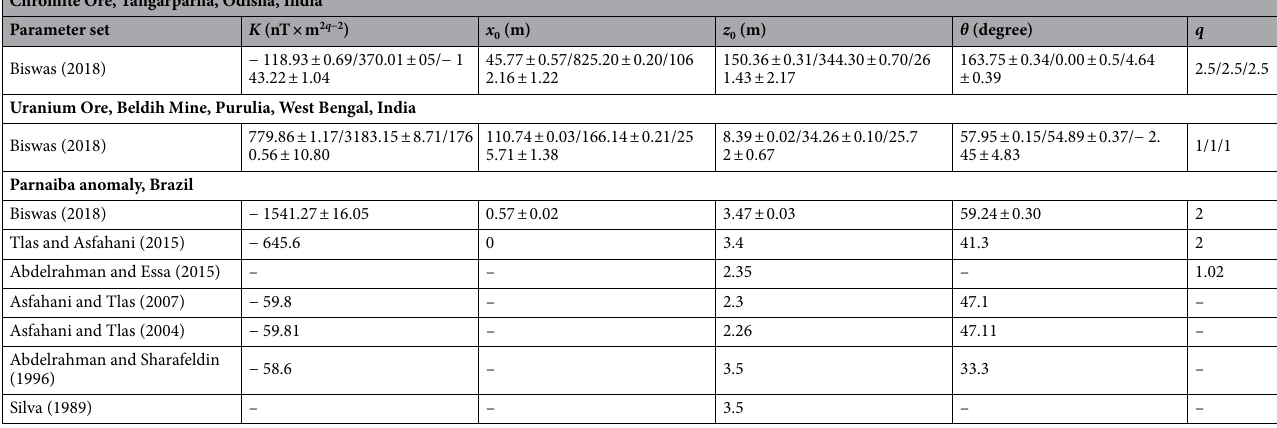
Table 4. Reported results of the field